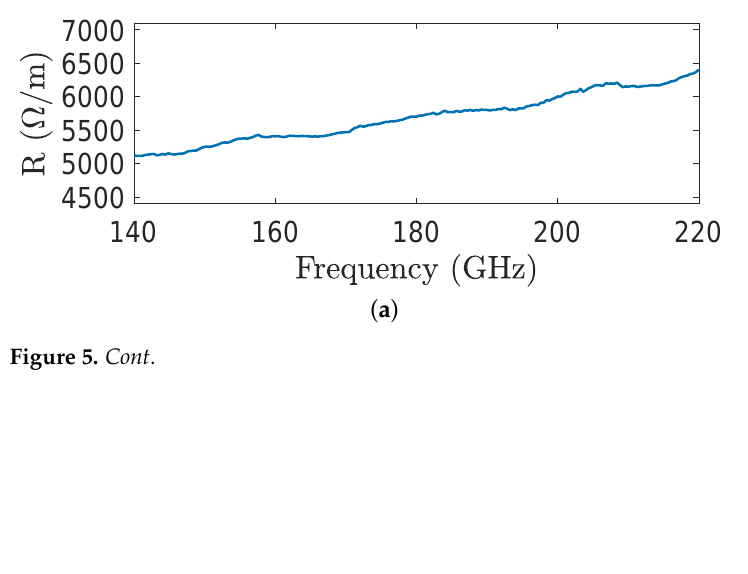
Figure 4. The extracted real part ( a ) and imaginary part ( b ) complex permittivity of de-ionized water within the broadband millimeter wave frequency range between 140 and 220 GHz, using the proposed fast and simple characterization algorithm.